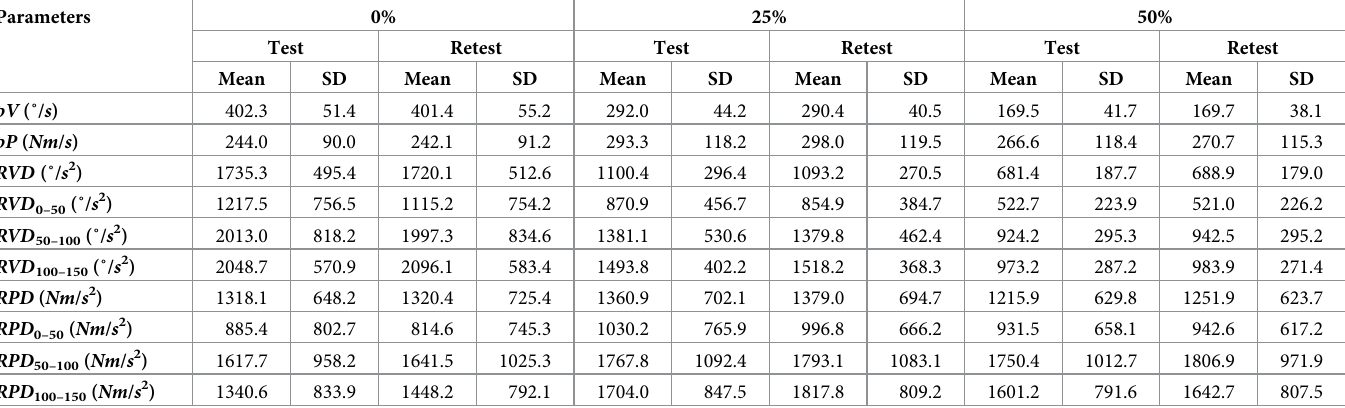
Table 1. Test and retest data (N = 63 ( ♂ 27, ♀ 36)). Parameters